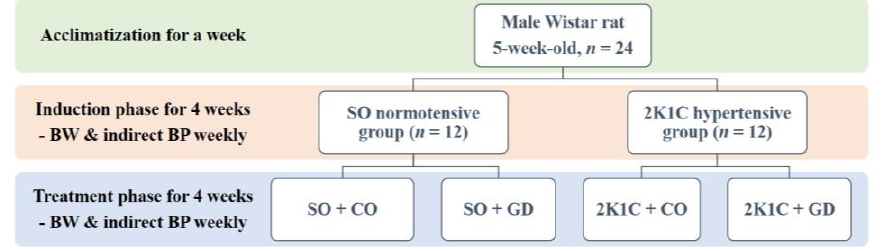
Figure 1. Schematic of the experimental design for this study.